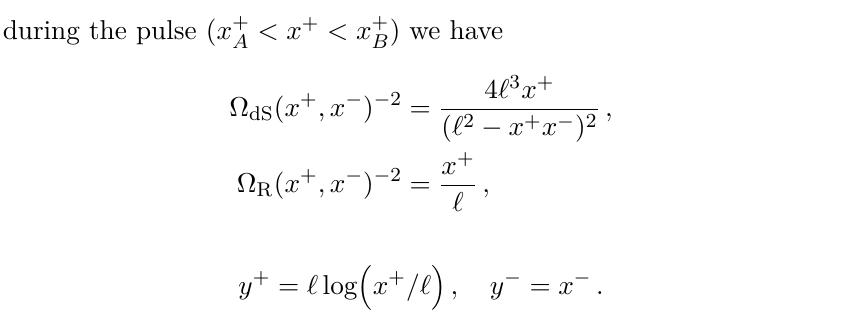
may reside before, during, or after the pulse. The r i